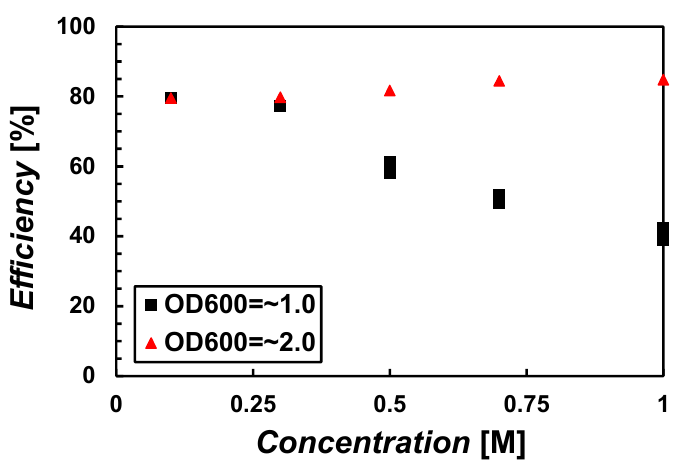
Figure 5. Precipitation efficiency with respect to recipes.